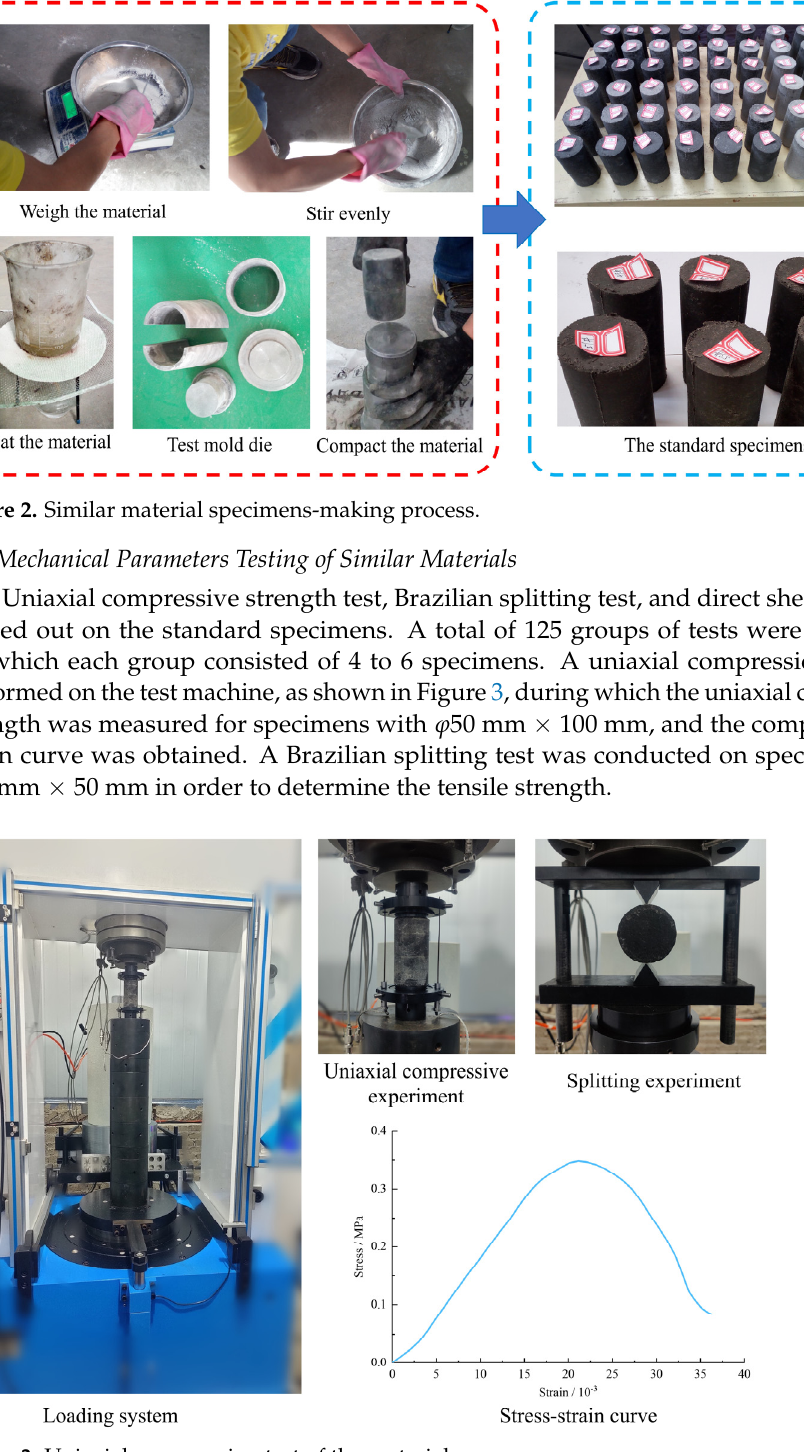
Figure 3. Uniaxial compression test of the material.